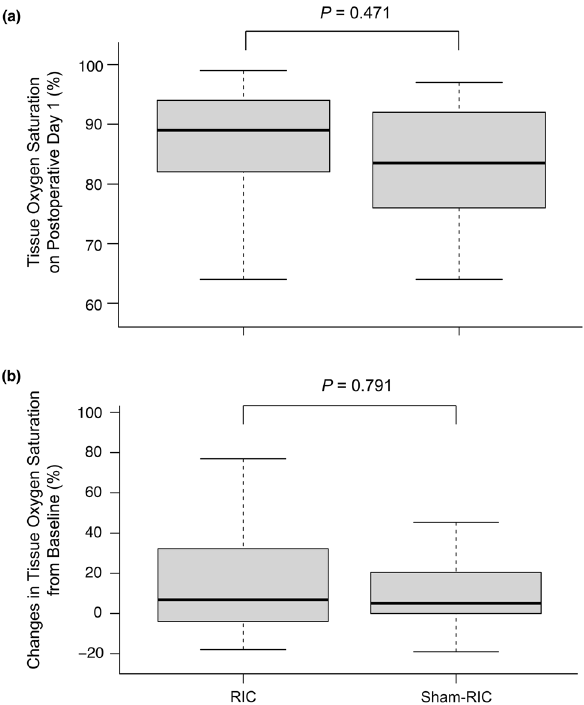
Figure 3. Boxplot of (a) tissue oxygen saturation of the flap on postoperative day 1 and (b) changes in tissue oxygen saturation of the flap site after free flap reconstruction compared to the baseline in the RIC and sham- RIC group. Horizontal line within the box indicates median values; lower and upper boundaries of the box indicate 25th and 75th percentiles, respectively; horizontal lines outside the box indicate the minimum and the maximum values of the data, respectively. Extreme outliers were omitted. RIC remote ischemic